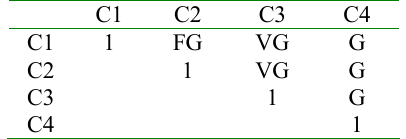
Table 4. Linguistic evaluation matrix of DM3 for main criteria